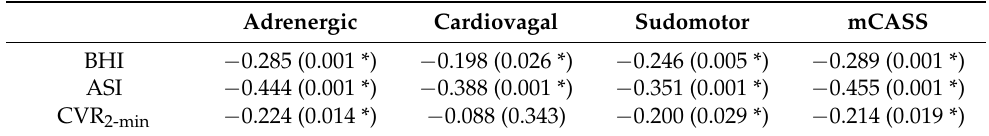
Table 5. Correlation analysis between autonomic function parameters and cerebral autoregulation parameters in patients with